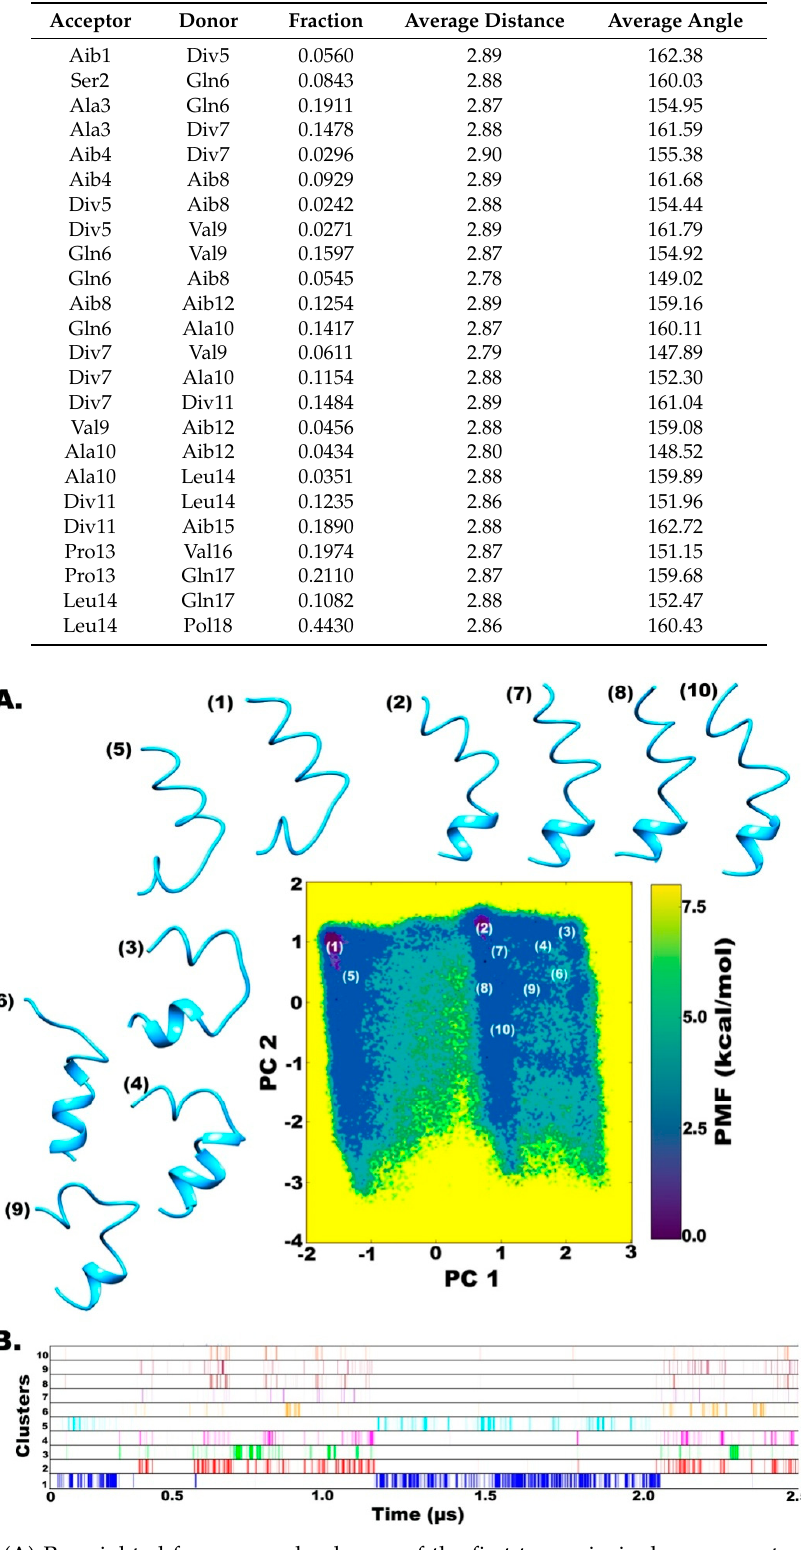
Figure 3. ( A ) Reweighted free energy landscape of the first two principal components calculated from dihedral angles, phi-psi, for better clustering based on internal motions. ( B ) Diagrammatic representation of cluster distribution along the simulation trajectory in water.